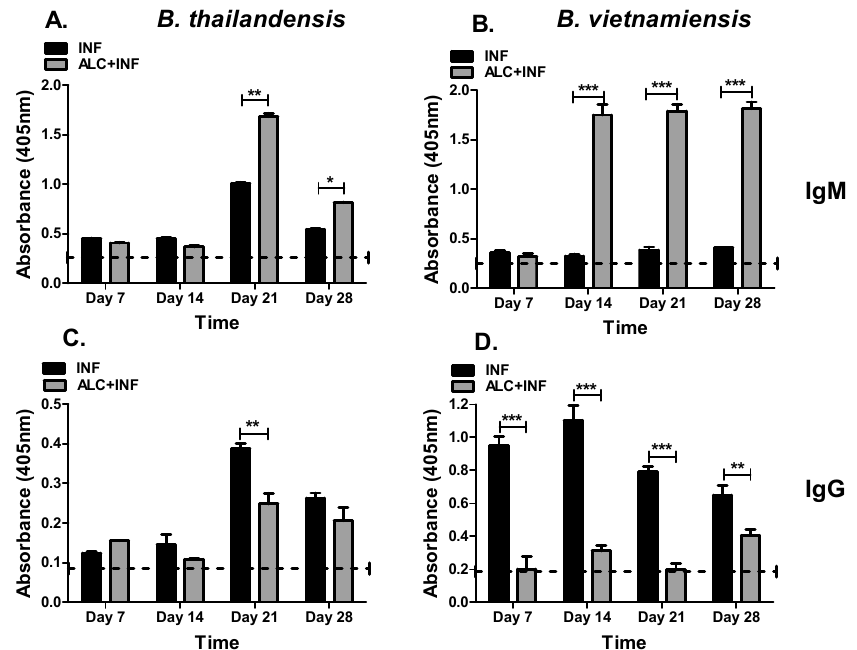
Figure 5. Specific IgM and IgG for B. thailandensis and B. vietnamiensis whole cell lysate (WCL). The mice were treated as described in Figure 3. Whole blood was collected weekly until 28 days PI. WCL